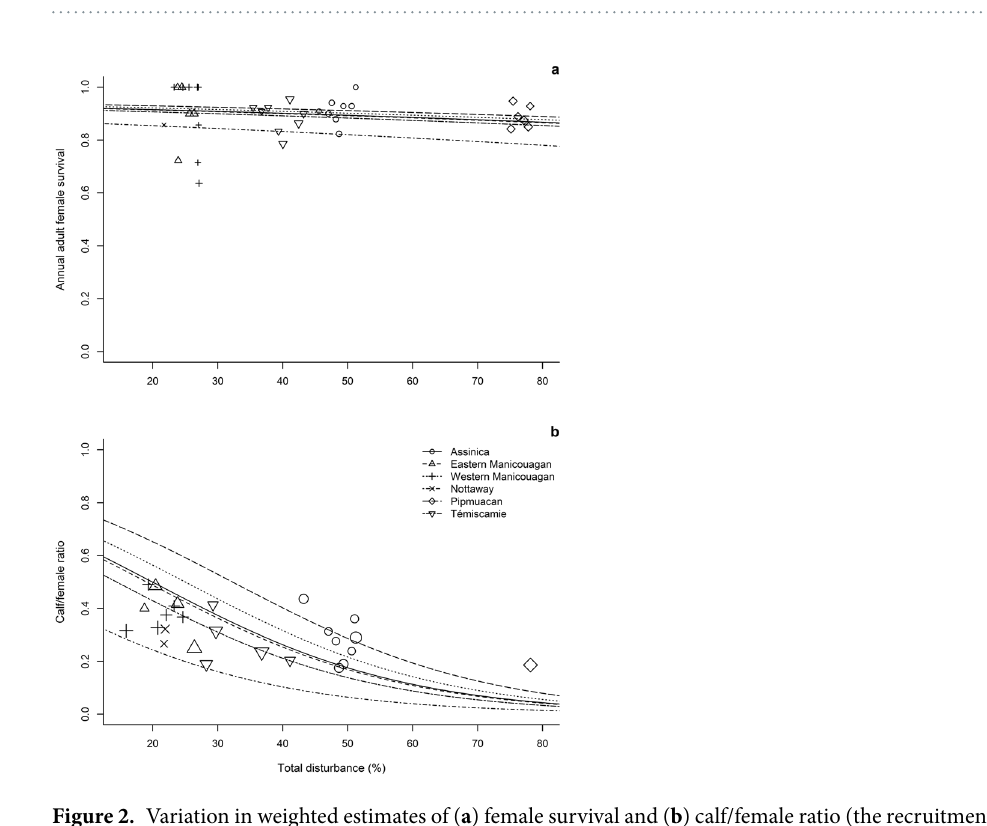
Figure 2. Variation in weighted estimates of ( a ) female survival and ( b ) calf/female ratio (the recruitment index) as a function of total disturbance within six ranges of boreal caribou in eastern Canadian boreal forest. Lines are predicted trends and symbols are the actual values, with the size reflecting the number of observed females during each year of survey (range: 6–22 females for survival; range: 50–252 females for recruitment